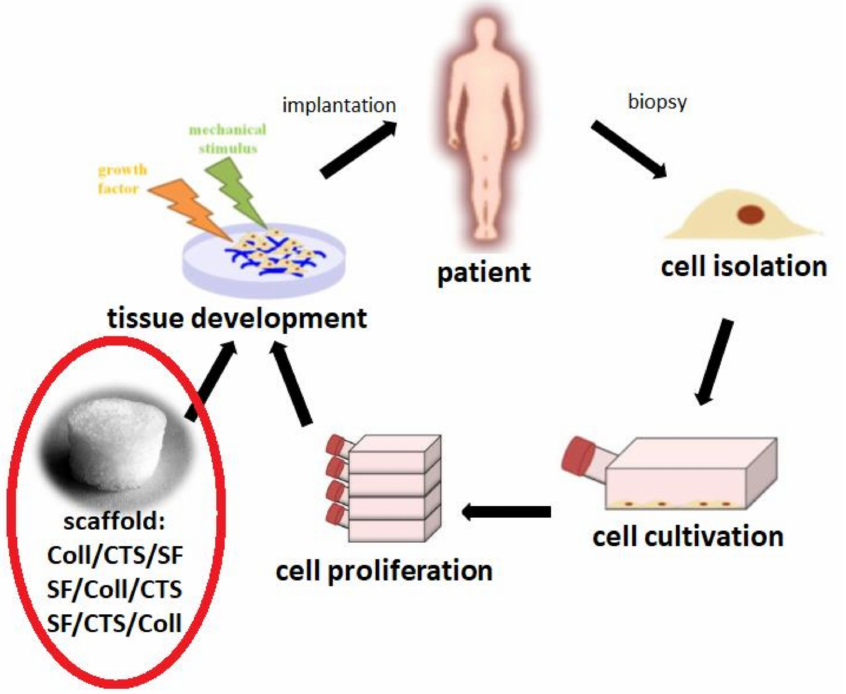
Figure 2. The steps of the tissue engineering process. In the red circle, the part of the tissue engineering round to which the article relates is crossed—design, physico-chemical characterization and in vitro study on cells of materials consisting of ternary mixtures based on silk fibroin, collagen and chitosan cross-linked with EDC/NHS